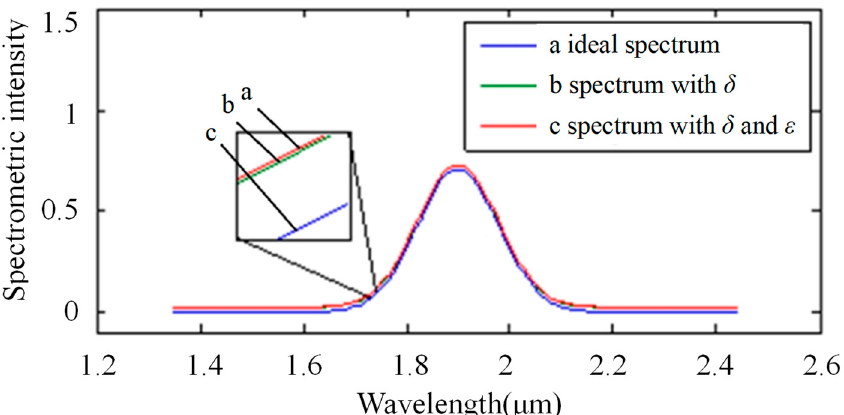
Figure 6. Impact of stray light on the spectrum in single-stripe mode: the horizontal ordinate shows the wavelength with units of micrometers. Additionally, the longitudinal coordinate shows the spectrometric intensity. Curve a shows the ideal spectrum, curve b shows the spectrum with the noise of variable stray light, and curve c shows the spectrum with the noise of two types of stray light, including variable stray light and intrinsic stray light.